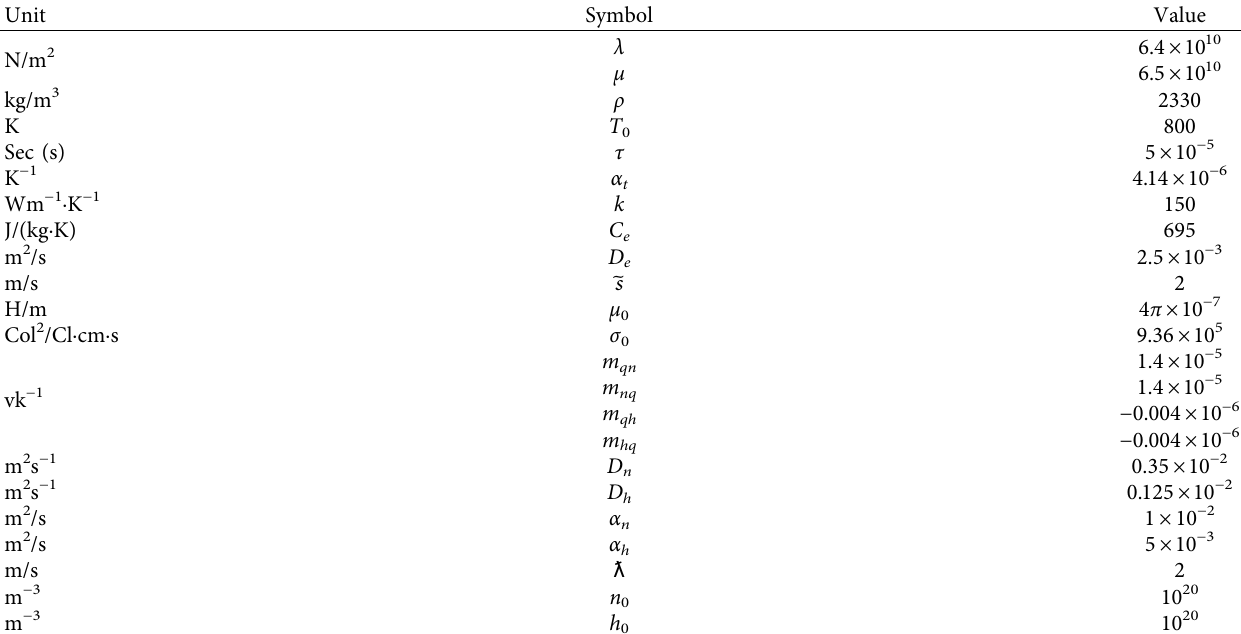
Table 1: Te physical input parameters of Si material in SI